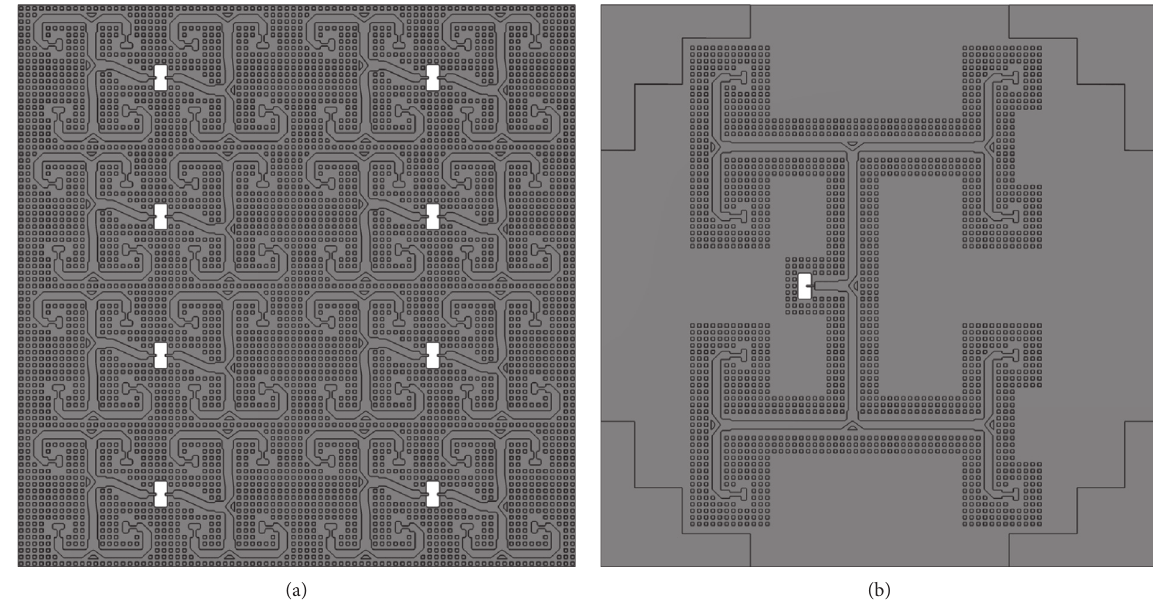
Figure 8: Feeding network of the 16 × 16 CP array antenna. (a) Feed-1 (top layer). (b) Feed-2 (bottom